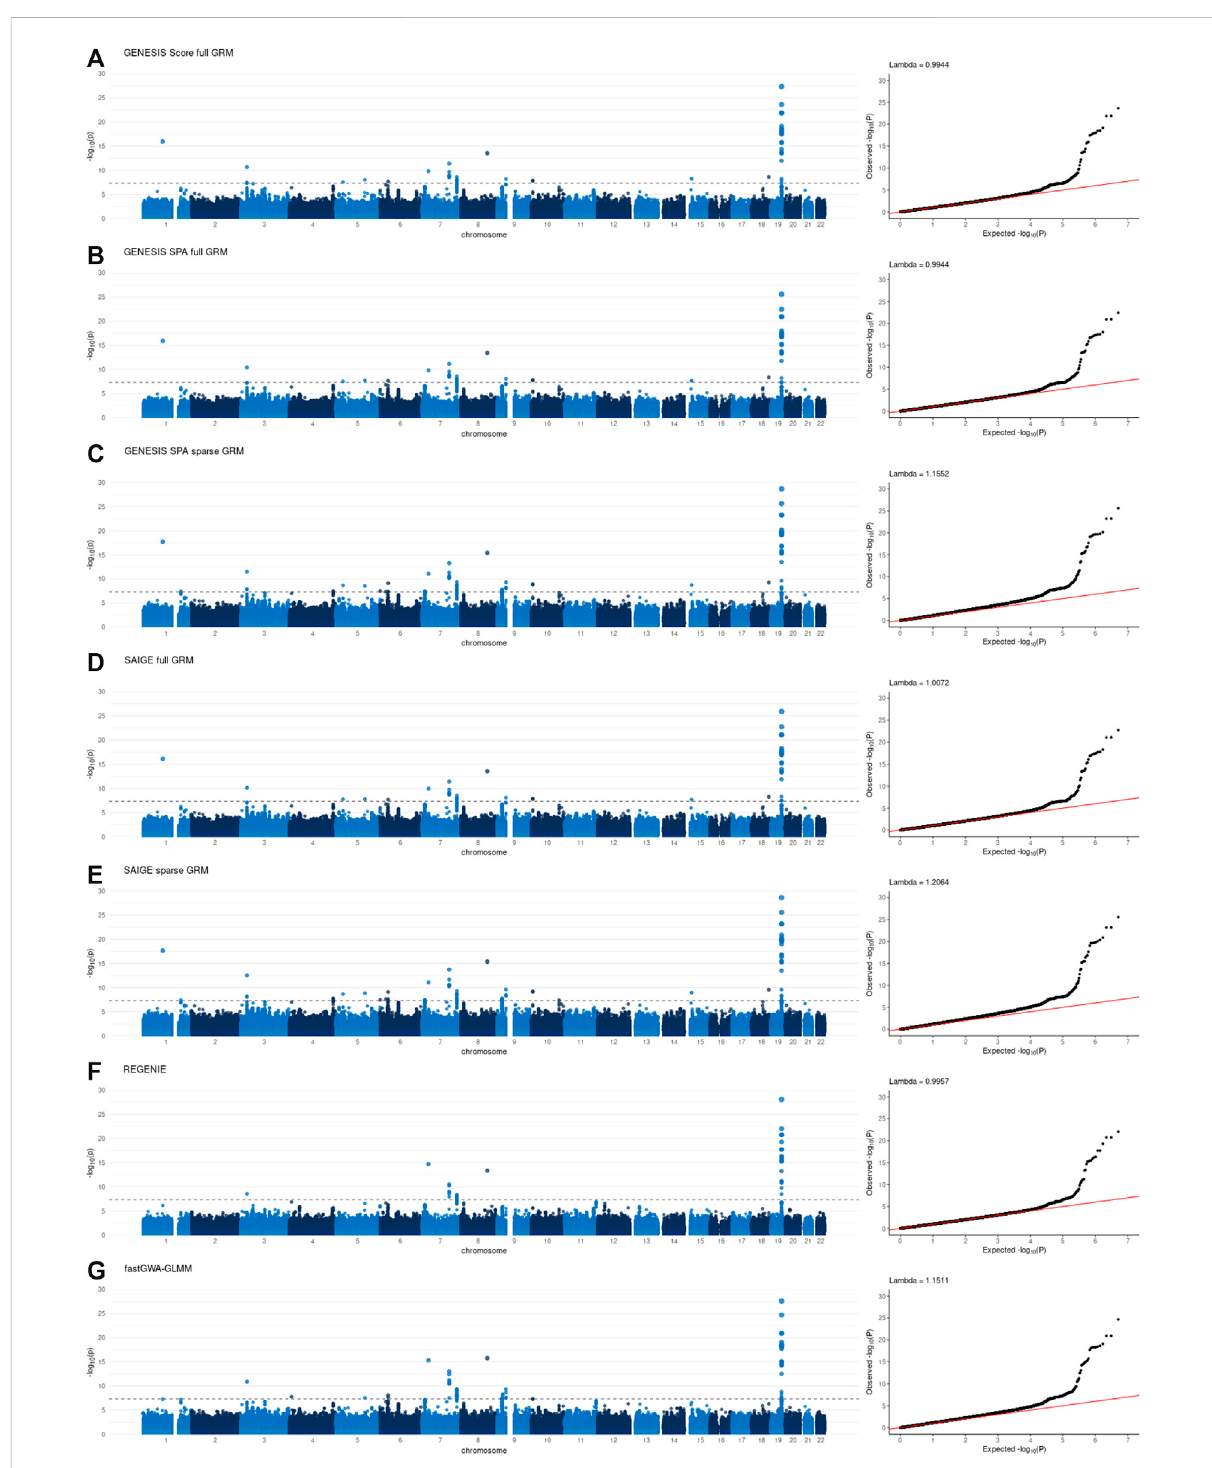
FIGURE 1 Manhattan and QQ plots of -log10( p -values) for the associations using imputed genotype data in the New England Centenarian Study (NECS) data. Panel (A) : associations based on the score test and adjusted for the full genetic relation matrix (GRM) using GENESIS. Panel (B) : associations based on the SPA and adjusted for the full GRM using GENESIS. Panel (C) : associations based on the SPA and adjusted for the sparse GRM using GENESIS. Panel (D) : associations based on the SPA and adjusted for the full GRM using SAIGE. Panel (E) : associations based on the SPA and adjusted for the sparse GRM using SAIGE. Panel (F) : associations based on the SPA and polygenic effect estimates to control for relatedness using REGENIE. Panel (G) : associations based on the SPA and adjusted for the sparse GRM using fastGWA-GLMM. Lambda is a genomic in fl ation